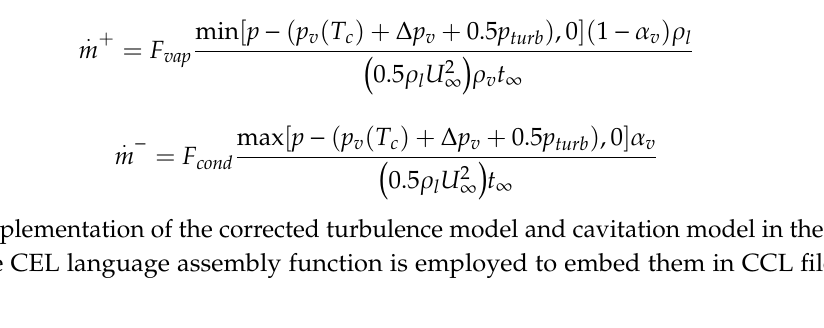
Figure 2. 3D model of the NACA0015 hydrofoil. 3.2. Mesh Implementation The ICEM CFD software is employed to mesh the NACA0015 hydrofoil into a hexahedral structured grid. The mesh grid around the NACA0015 hydrofoil is shown in Figure 3. The mesh quality of the boundary layer around the hydrofoil has a great influence on the accuracy of numerical simulation results. The y + value is usually employed to judge the mesh quality [31-32]. There is no specific range for the distribution of the y + value for different turbulence models. The y + value is usually maintained under 60 to keep the accuracy of the simulation results in the research community. In order to improve the quality of the mesh grid, a refined C-shaped structure grid is used around the leading edge and trailing edge of the hydrofoil. The distribution of the y + value on the upper and lower surfaces of the hydrofoil is shown in Figure 4. Figure 3. Mesh implementation around the hydrofoil. (a) Mesh around leading edge, (b) Mesh around trailing edge